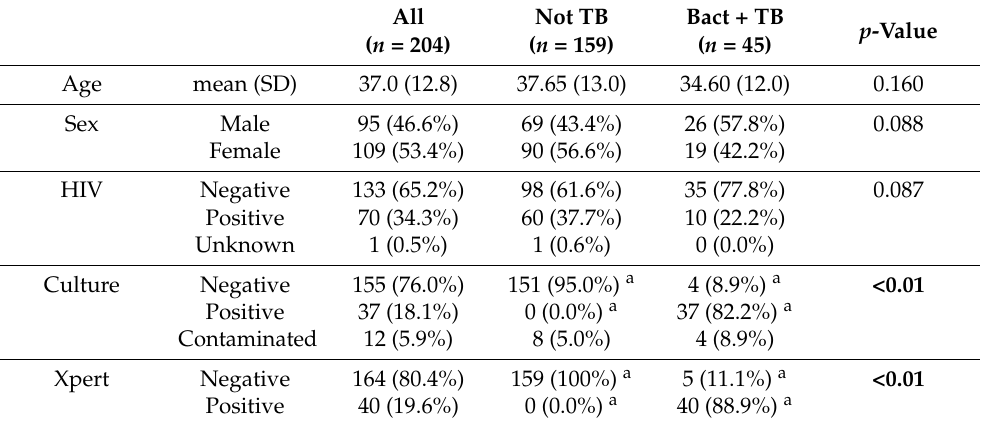
Table 1. Characteristics of the study